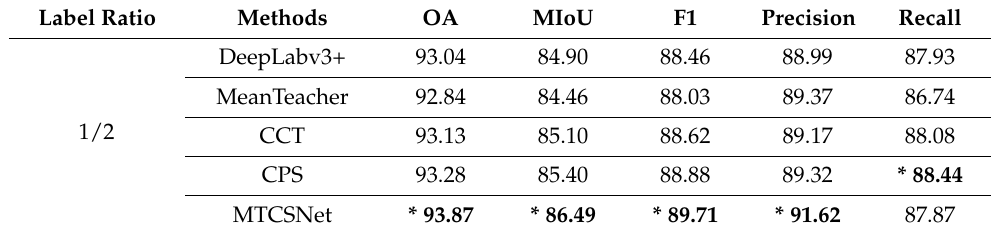
16 of 21 Table 6. Quantitative performance comparison on the GF1-WHU dataset. Label Ratio